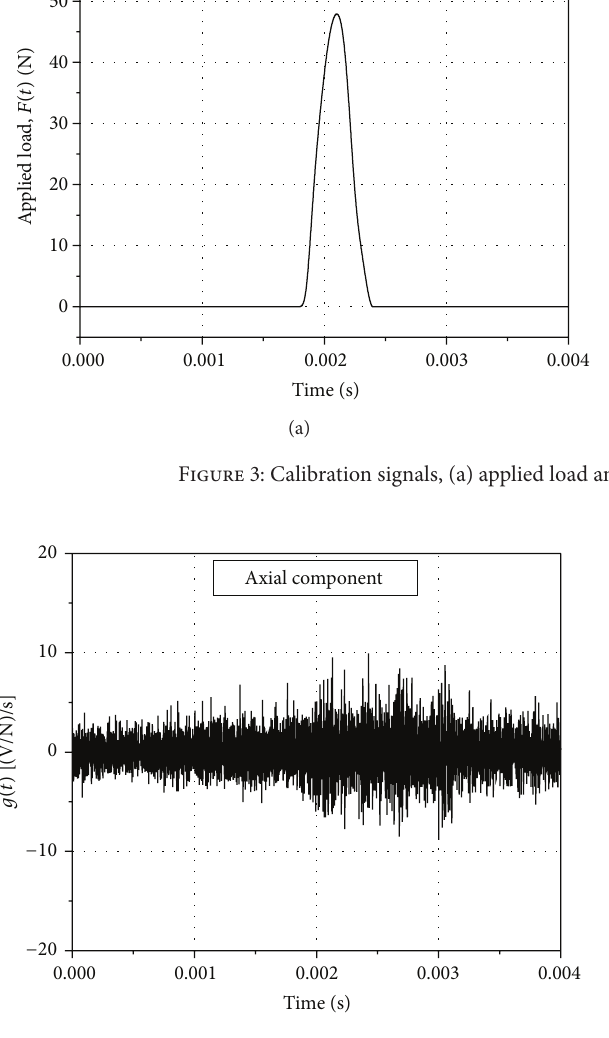
Figure 4: System response function for axial